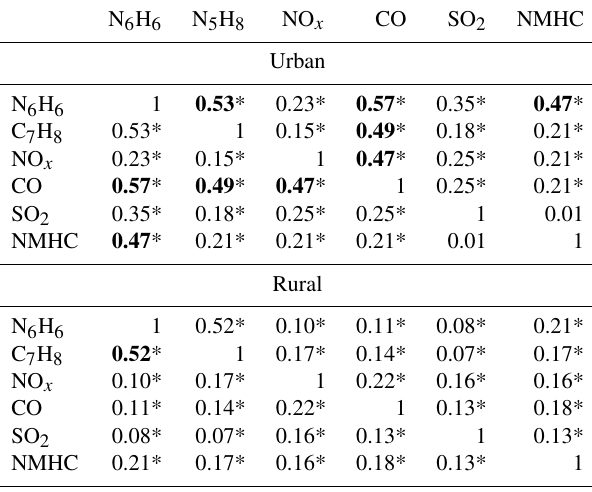
Table 6. Pearson correlation matrix for urban and rural measurements along the Trans-Siberian Railway. R ≥ 0.5 are shown in bold. Asterisks show statistically significant correlations for P = 0.05. All impurities are in ppb except for NMHC and CO